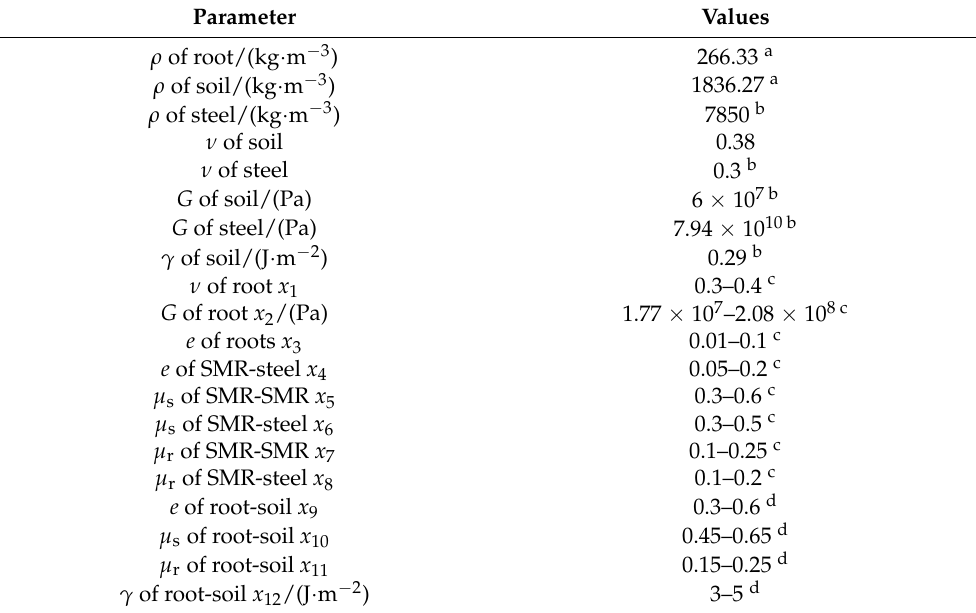
Table 3. Parameters of AOR simulation model for SMR and